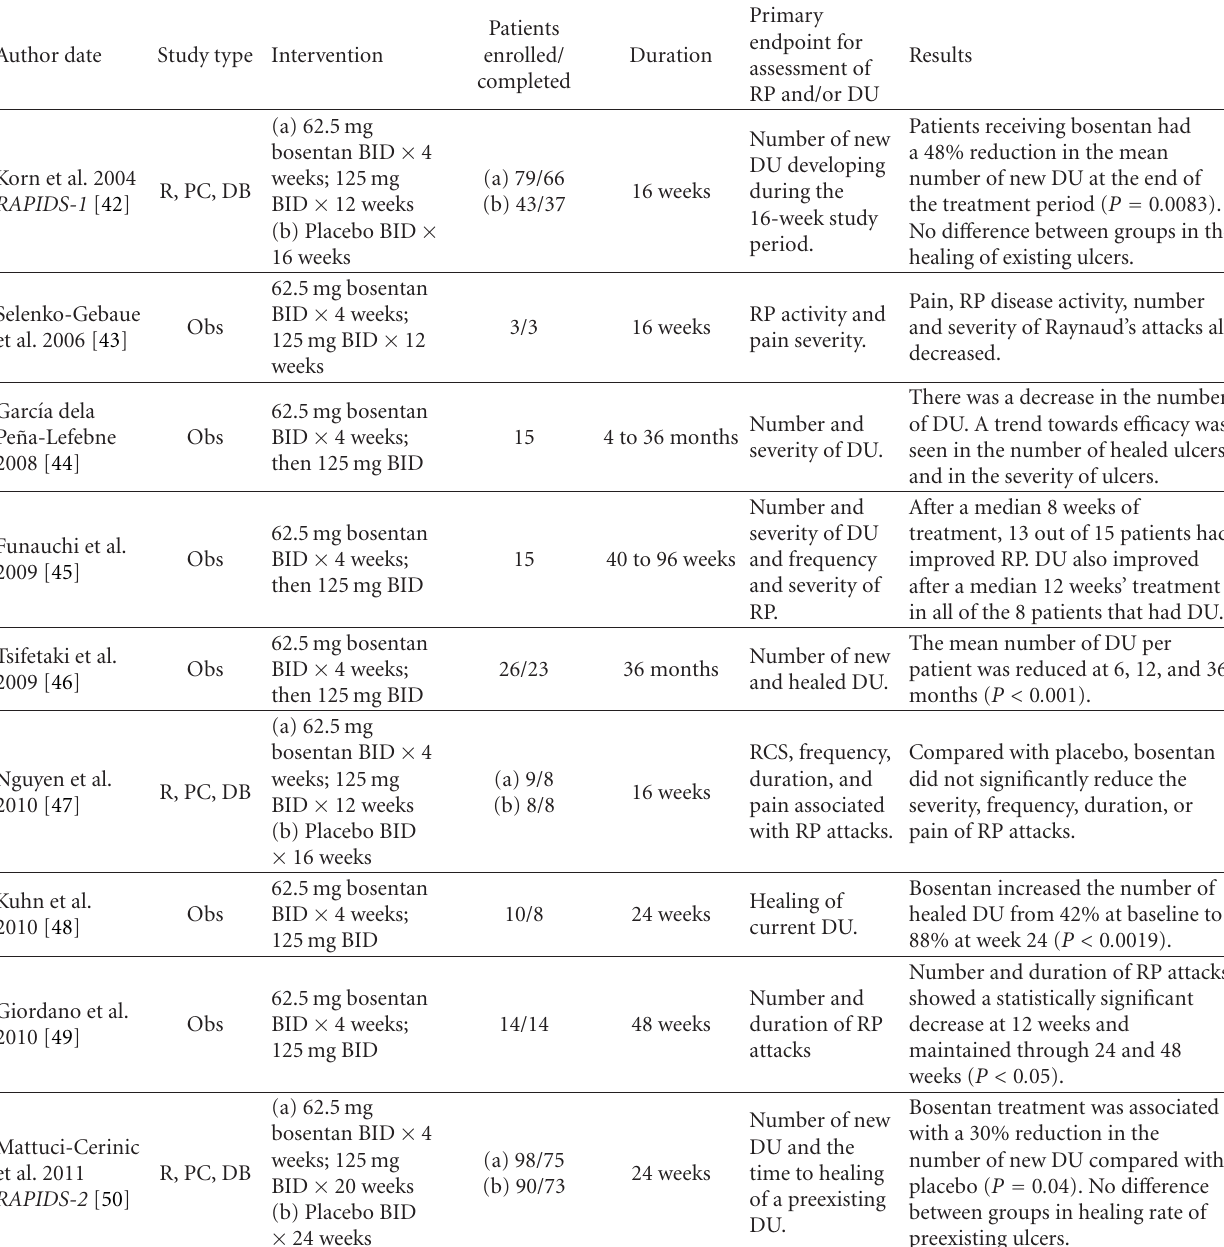
Table 3: Studies evaluating e ffi cacy of endothelin receptor antagonists for systemic sclerosis-associated raynaud’s phenomenon and/or digital